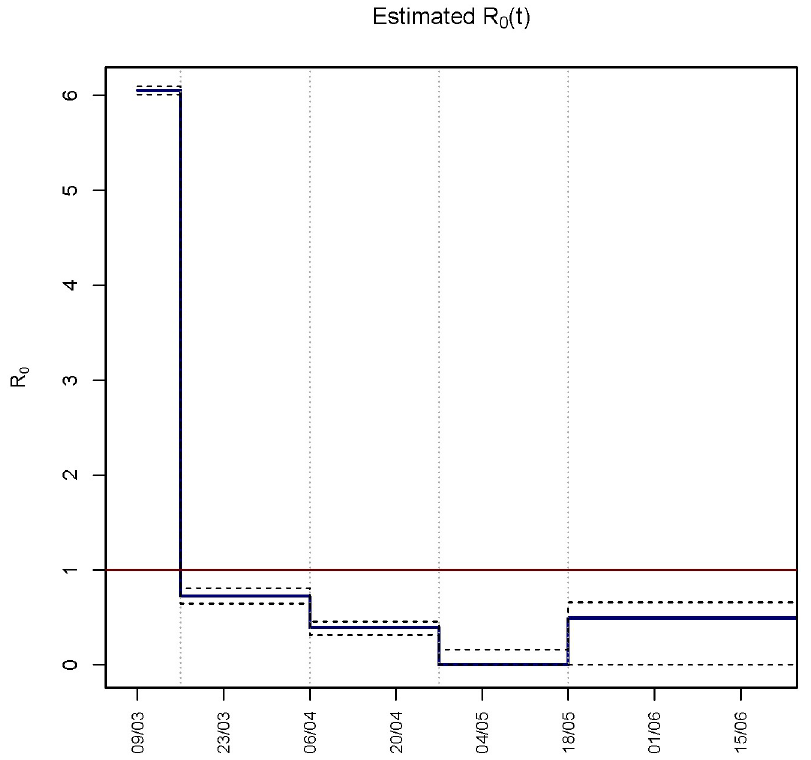
Fig 4. Estimated R 0 ( t ) with 90% confidence